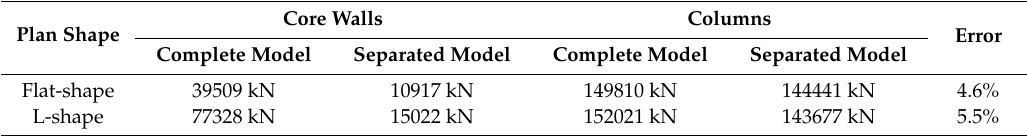
Table 4. Comparison of total axial forces.